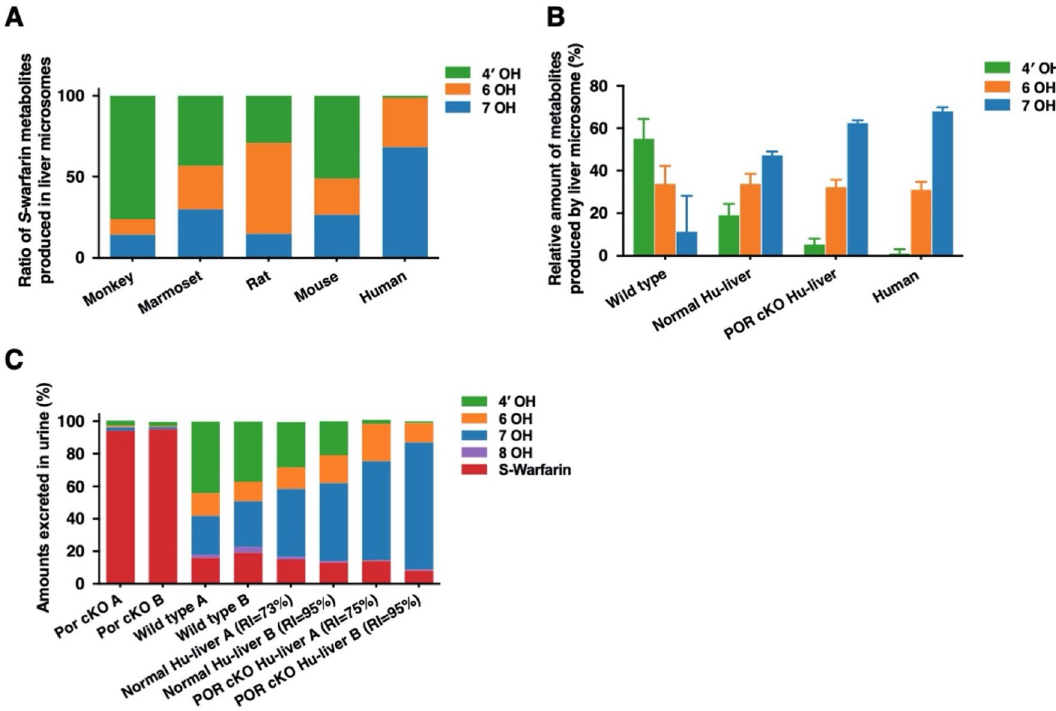
Figure 5. Characterization of S -warfarin metabolism in POR cKO humanized liver mice. ( A ) Species- dependent regioselective S -warfarin hydroxylation in various animal liver microsomes. S -warfarin (10 μM) was incubated with pooled liver microsomes (0.20 mg/mL) at 37 °C for 20 min. ( B ) S -warfarin metabolism in pooled liver microsomes from wild-type (six males), humanized liver TK-NOG (Normal Hu-liver, four males) mice, POR cKO humanized liver (POR cKO Hu-liver, four males) mice, and humans. S -warfarin (10 μM) were incubated with the liver microsomes (0.20 mg/mL) at 37 °C for 20 min. ( C ) Cumulative urinary excretions of S -warfarin and its metabolites for 72 h after intravenous administration (4.0 mg/kg) in wild-type, POR cKO, Normal Hu-liver, and POR cKO Hu-liver mice. The 4 ′ -, 6-, 7-, 8-, and 10-hydroxywarfarin were measured for urine samples treated with β-glucuronidase. The data presented are from two